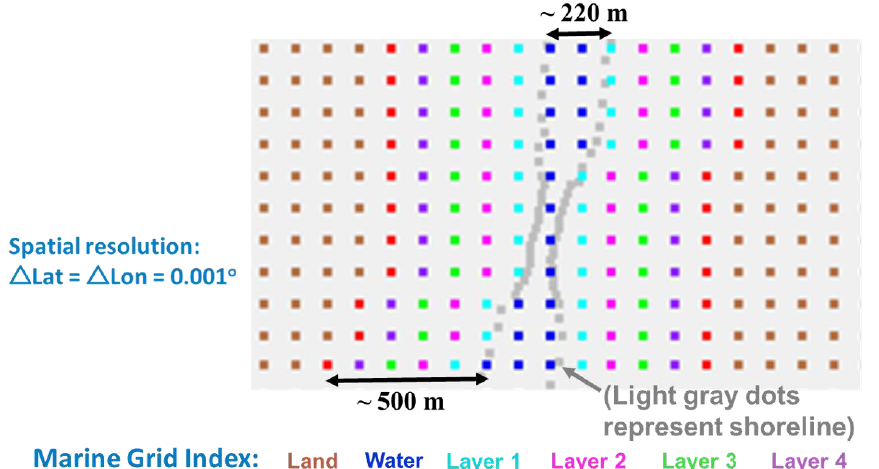
Figure 15. An example of the detailed marine grid field surrounding a narrow water path (light gray dots). The marine grids at land and in water are marked in brown and blue, respectively. The artificially added water layers 1 to 5 are marked in cyan, pink, green, purple, and red,